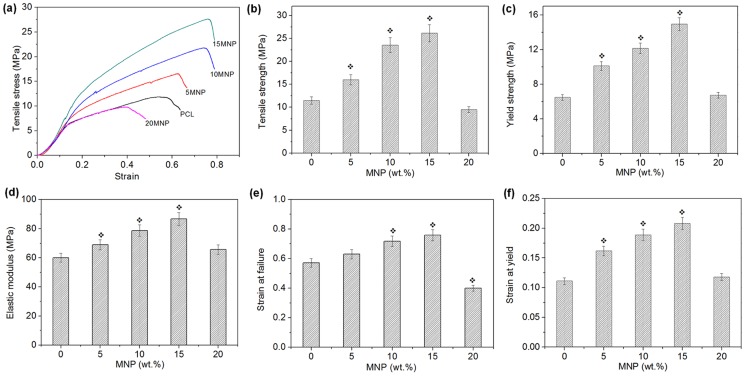
Tensile mechanical properties of the PCL and PCL-MNP nanocomposite nanofiber scaffolds.(a) stress-strain curve, (b) tensile strength taken from the maximum stress prior to a failure, (c) yield strength, measured at yield point, (d) elastic modulus, taken from the initial slope in stress-strain curve, (e) strain at failure, taking as elongation rate, (f) strain at yield, measured at yield point. The addition of MNP up to 15% gradually increased all the mechanical properties measured, which however, decreased with further addition of 20%. Tests were carried out on five individual specimens and average and one standard deviation values were plotted.